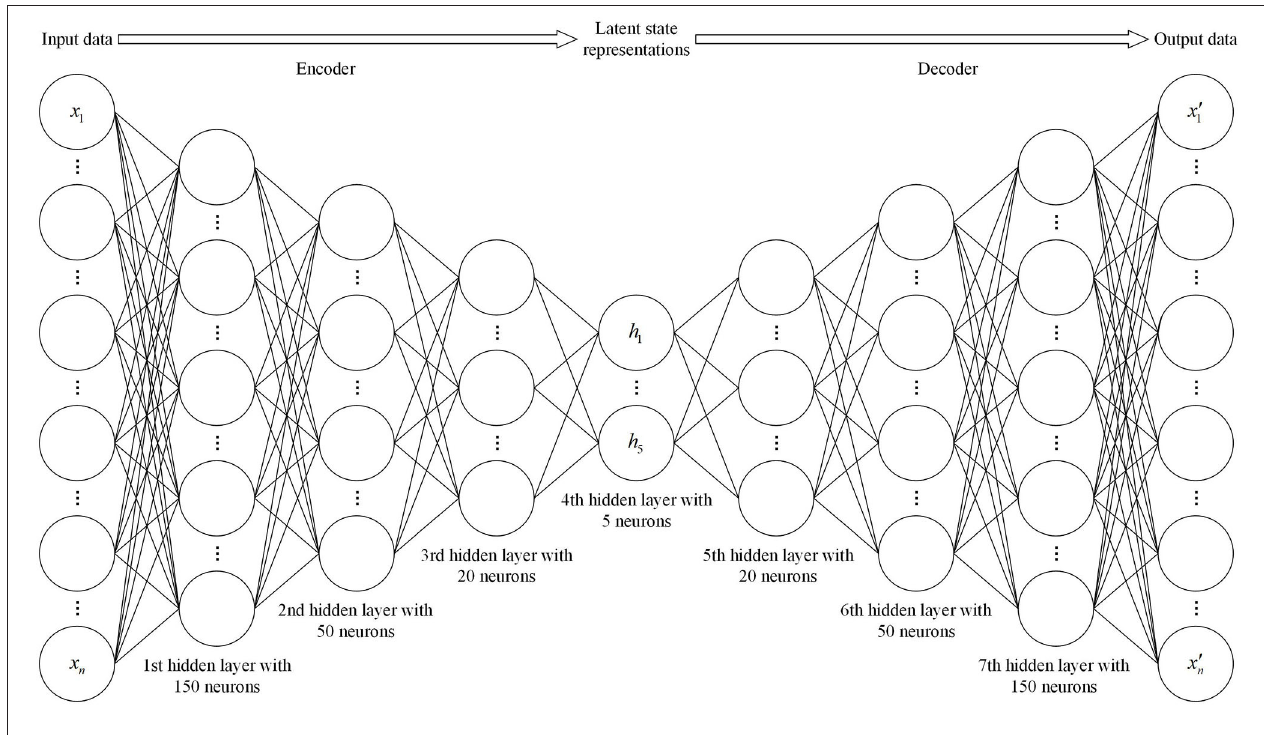
FIGURE 4 | Architecture of the stacked auto-encoder.